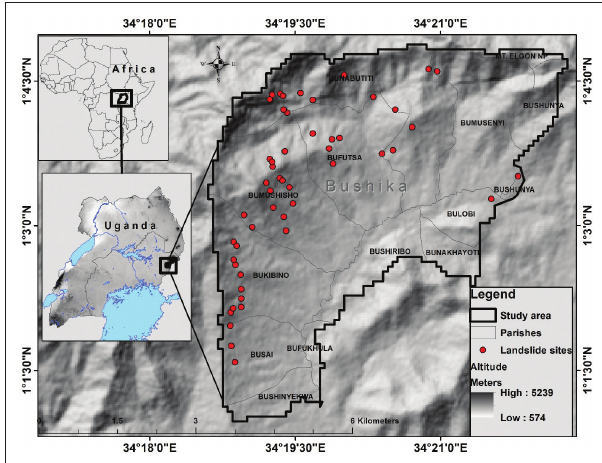
FIGURE 1: Showing the mapped landslide